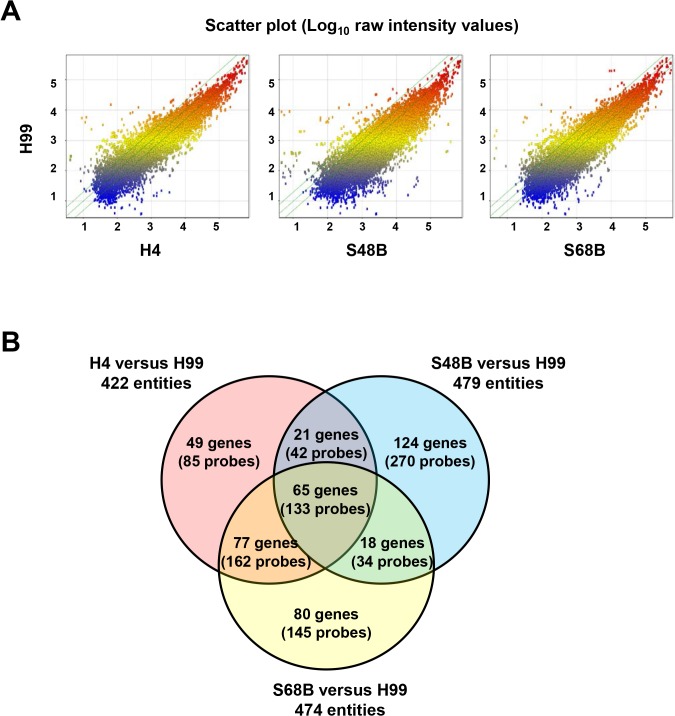
Gene expression of H99 versus environmental strains.(A) Scatter plots show the expressions of total probes in the H99 versus H4, S48B or S68B. X and Y axis show log10 raw intensity values. (B) Venn diagram. Significantly regulated probes (FC>2 or FC<-2, P<0.05) were selected from the comparisons of H99 versus each environmental strain. Venn diagram shows the distribution and the number of the genes (probes) in each fraction.